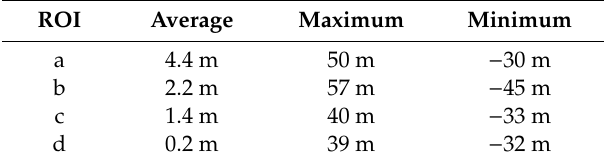
Table 3. Elevation values extracted for each of the ROIs shown in Figure